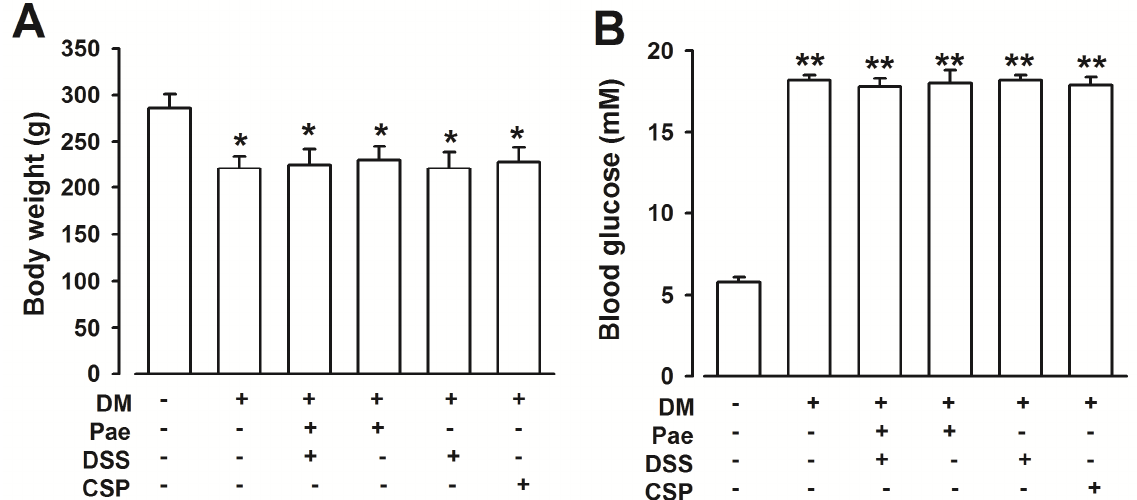
Figure 2. Effects of Pae + DSS and CSP (serves as a positive control) on body weight and blood glucose of diabetic rats. ( A ) Body weight significantly decreased in diabetic rats ( n = 6) compared with that of normal rats ( n = 20). Pae + DSS and CSP administration ( n = 6) did not improve body weight loss in diabetic rats. ( B ) Blood glucose increased in diabetic rats ( n = 6) compared with that of at of normal rats ( n = 20). Pae + DSS and CSP administration ( n = 6) did not decrease the high blood glucose in diabetic rats. * p < 0.05, ** p < 0.01 compared with normal rats. DM = Diabetes Mellitus ; Pae = Paeonol; DSS = Danshensu; CSP = Compound salvia pellet.